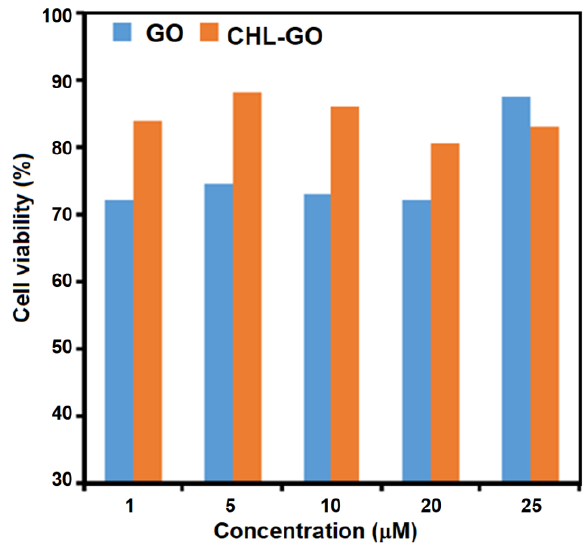
Figure 6. Cytotoxic study of GO and GO loaded with CHL.